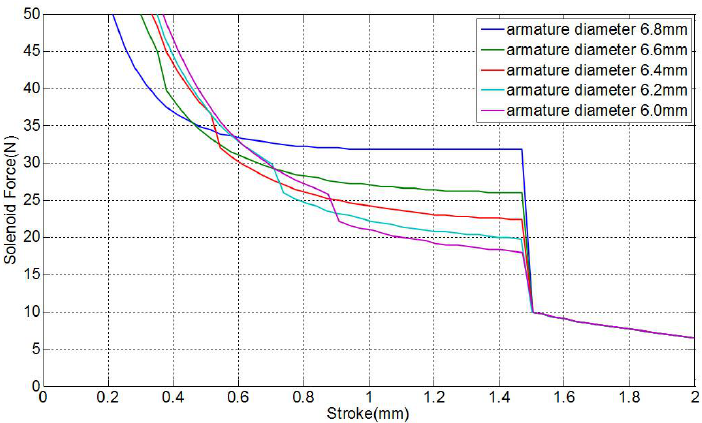
Figure 14. Simulation results for the armature diameter.